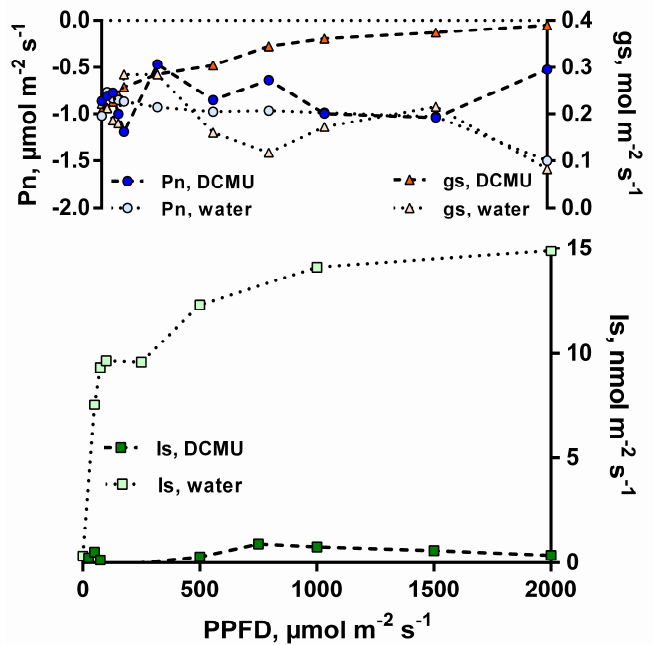
Figure 3. Leaf isoprene emissions ( Is , nmol m − 2 s − 1 ), net photosynthesis rates ( Pn , µ mol m − 2 s − 1 ), and stomatal conductance ( gs , mol m − 2 s − 1 ) from an I. edulis leaflet under constant leaf temperature (30 ◦ C) as a function of PPFD intensity under CO 2 -free atmosphere with and without the addition of the photosynthesis inhibitor DCMU in the transpiration stream ( n = 1).